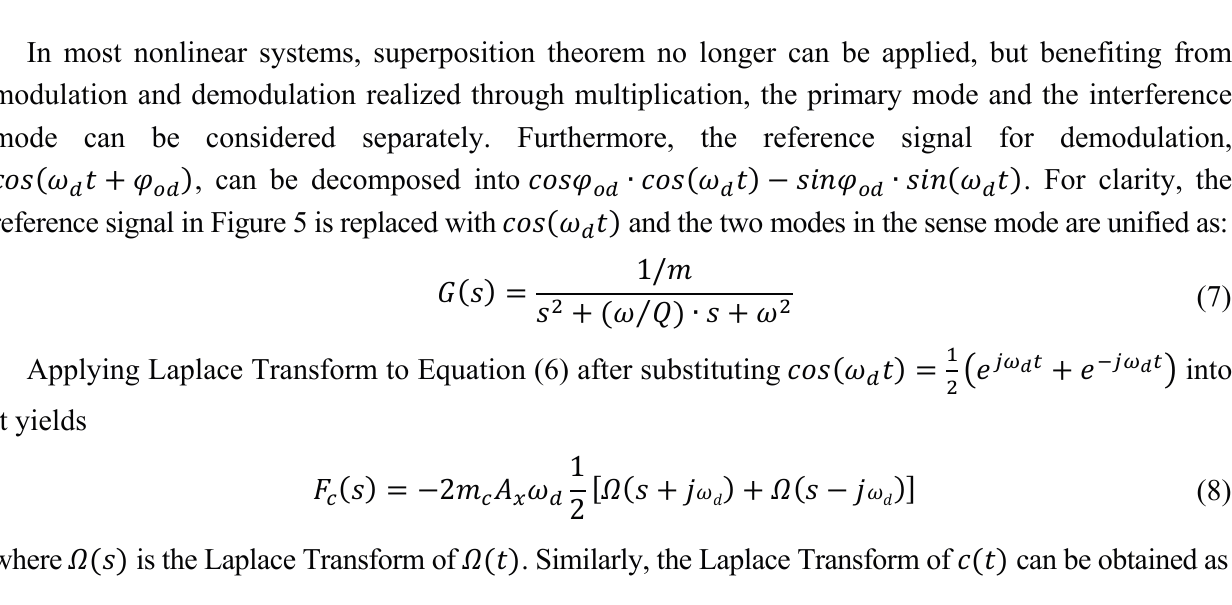
Figure 5. The sense block diagram of the